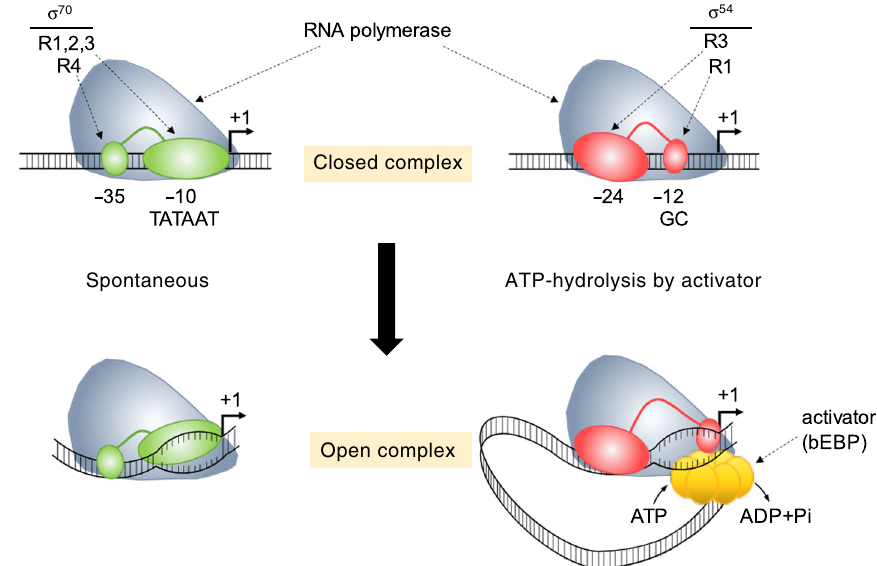
Fig. 1 Transcription initiation at σ 70 and σ 54 controlled promoters of bacteria 1,2,13 . σ 70 and σ 54 direct RNA polymerase to bacterial promoters to form the closed complex. Regions (R) 1,2,3 and 4 of σ 70 bind to DNA elements at position − 10 (consensus sequence: TATAAT) and − 35, while R1 and R3 of σ 54 bind to sequences at position − 12 (consensus sequence: GC) and − 24 upstream of the transcriptional start site ( + 1). Open complex formation during transcription initiation occurs spontaneously at σ 70 controlled promoters but requires the mechonchemical energy derived from ATP-hydrolysis by an activator, a bacterial enhancer binding protein (bEBP), at σ 54 controlled